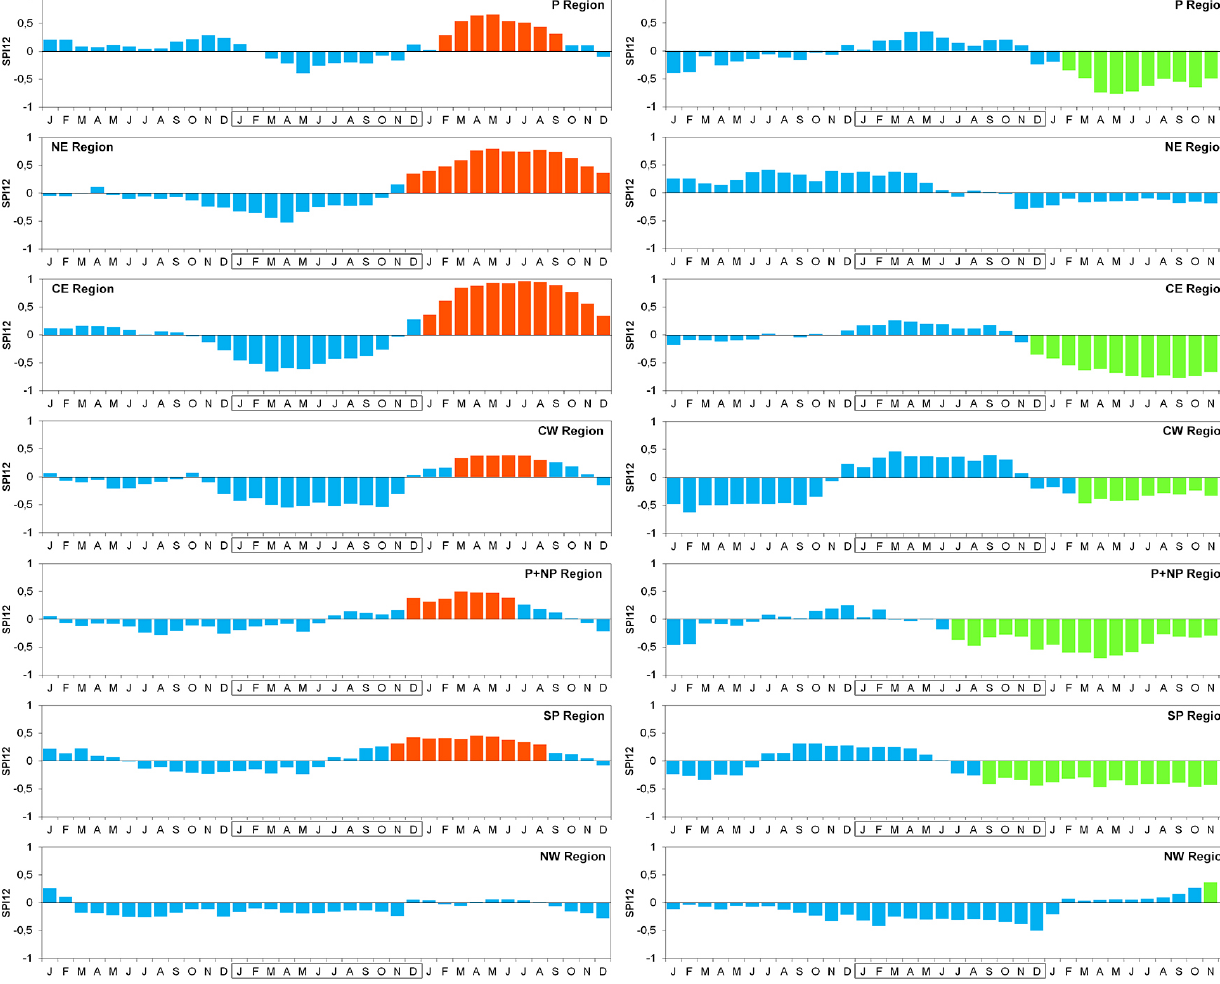
Figure 6. Same as Fig. 4 for